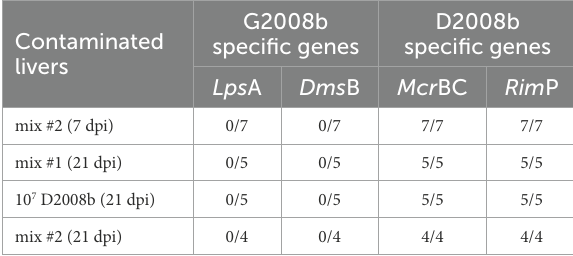
TABLE 4 Identification of Campylobacter jejuni strains from contaminated livers by strain specific